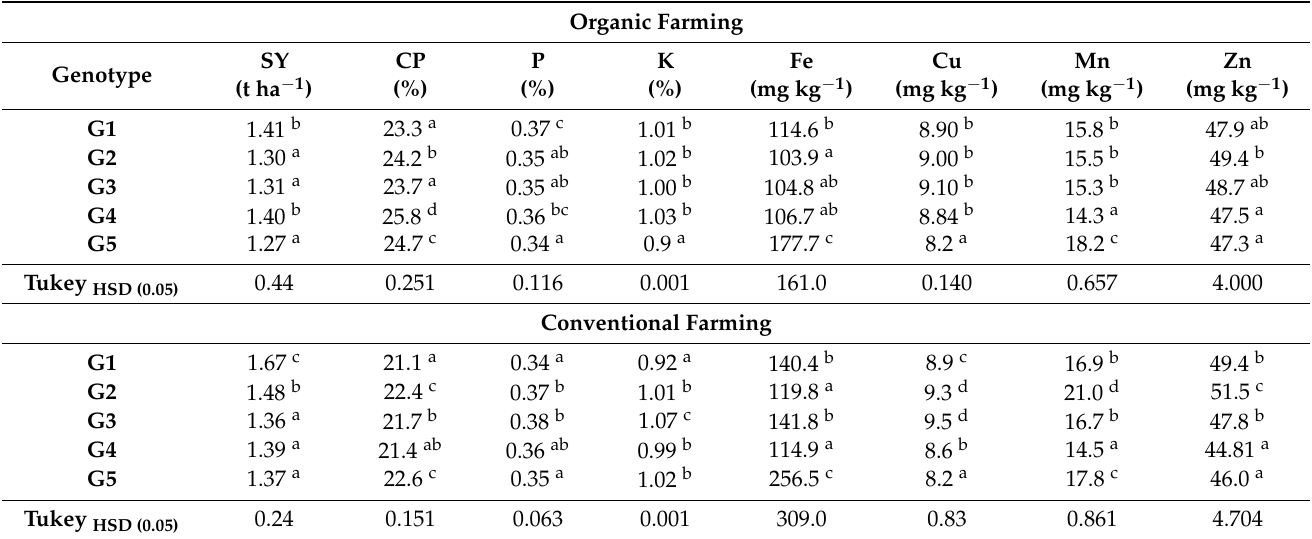
Table 2. Comparison of means for seed yield (SY), seed crude protein (% CP), seed macronutrient (% P, K) and micronutrient (Fe, Cu, Mn, Zn, mg kg − 1 ) contents of five lentil genotypes (G) at harvest across the eight environments in organic and conventional